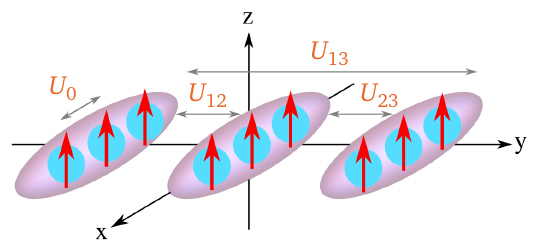
Figure 12: Schematic representation of the device. The cigar-shapes (purple), represent dipolar Bose-Einstein condensates, whose Gaussian distribution occurs predominantly in the x -direction. Dipole-dipole interactions are characterized by = U = α U = U U , and U is the integrability condition. Recall 12 23 0 13 0